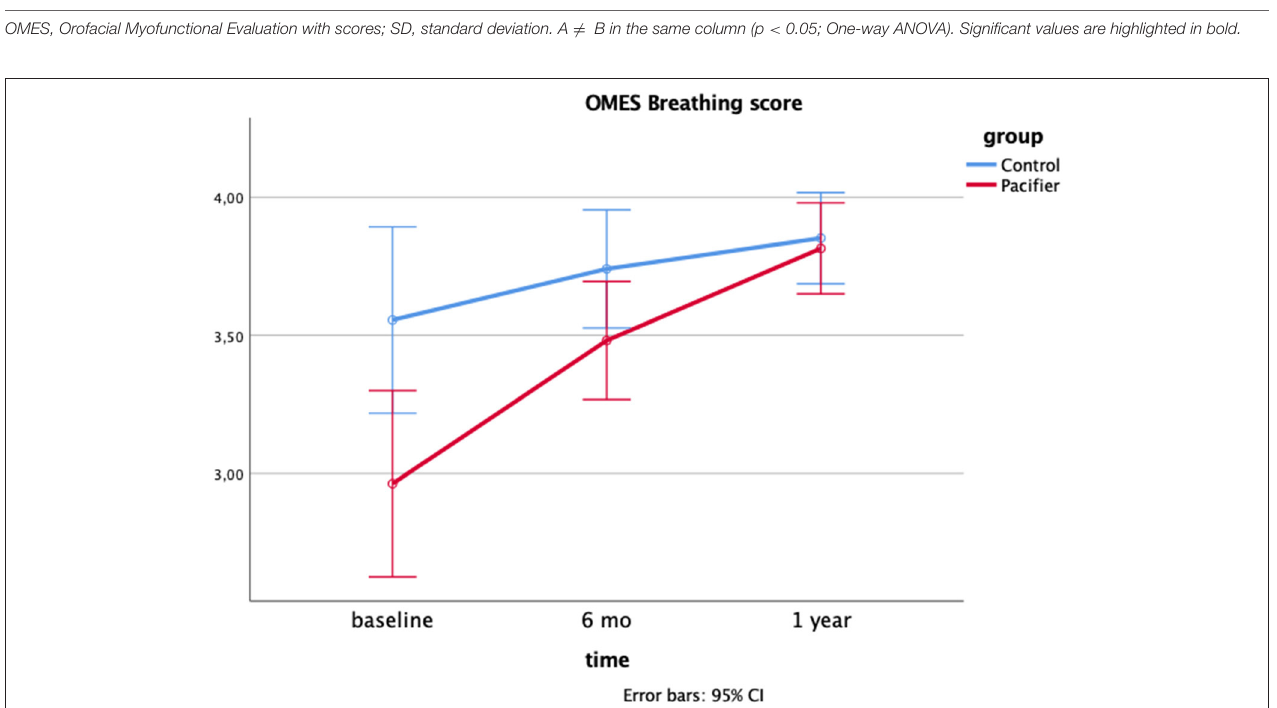
Frontiers in Pediatrics |